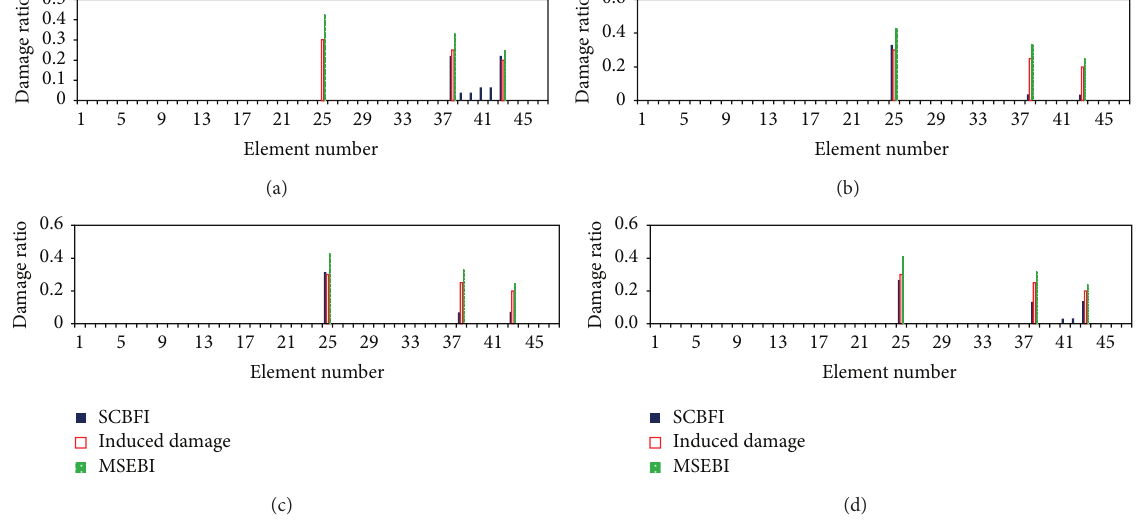
Figure 12: Comparison of damage index SCBFI with MSEBI for 47-bar planar truss for case 4 considering (a) 1 mode, (b) 2 modes, (c) 3 modes, and (d) 4 modes.